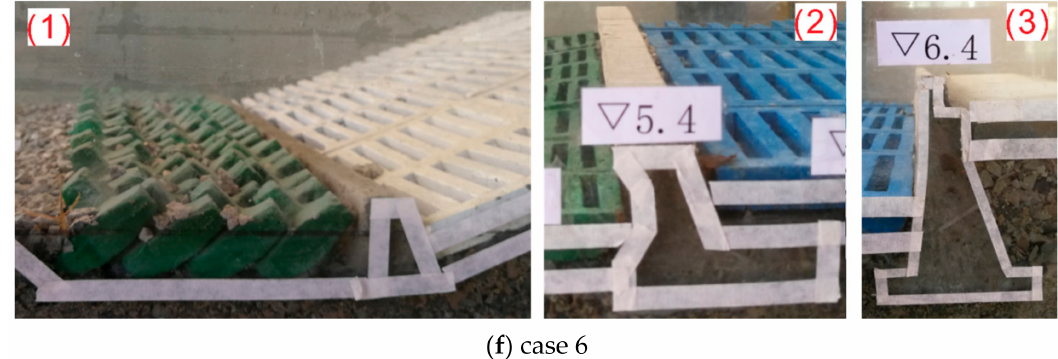
Figure 8. State of each part of the breakwater model ( a – f